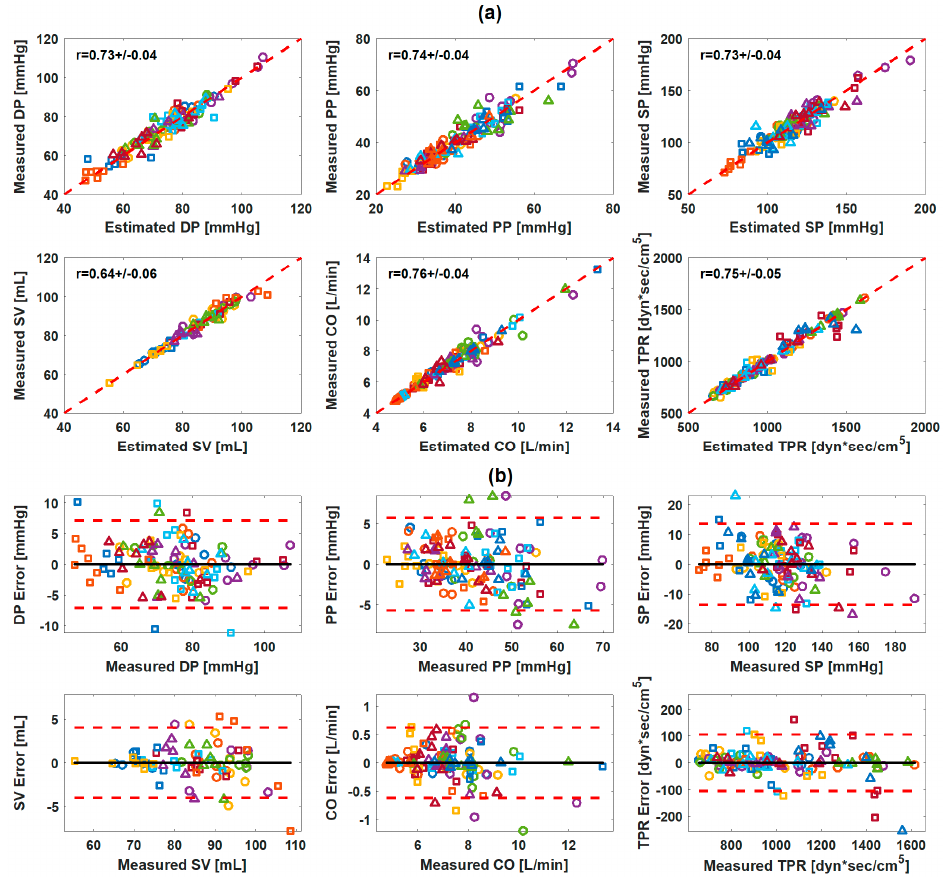
Figure 5. Correlation and Bland–Altman plots between measured versus regressed cardiovascular parameters: synthetic weighing scale ballistocardiogram (BCG) transformed from armband BCG. ( a ) Correlation plots. ( b ) Bland–Altman plots.